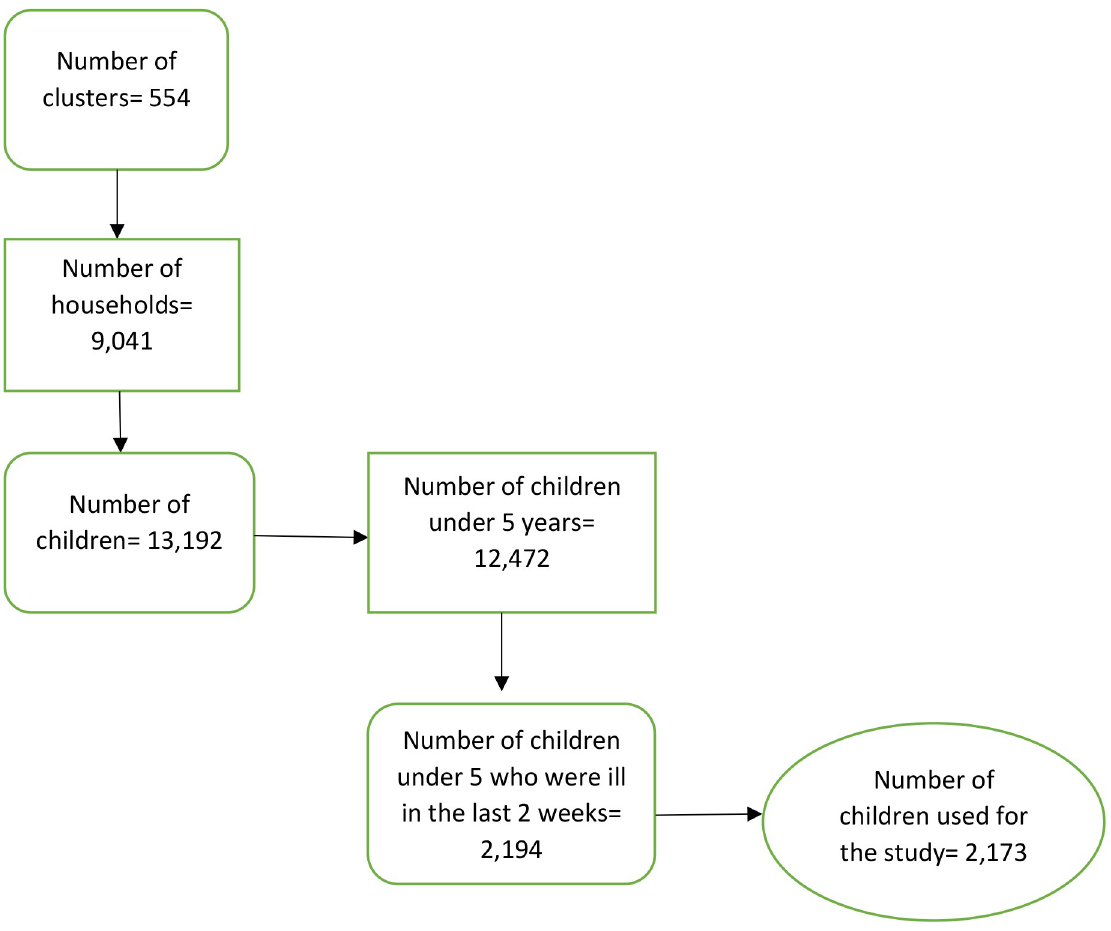
Fig 1. Flowchart showing the